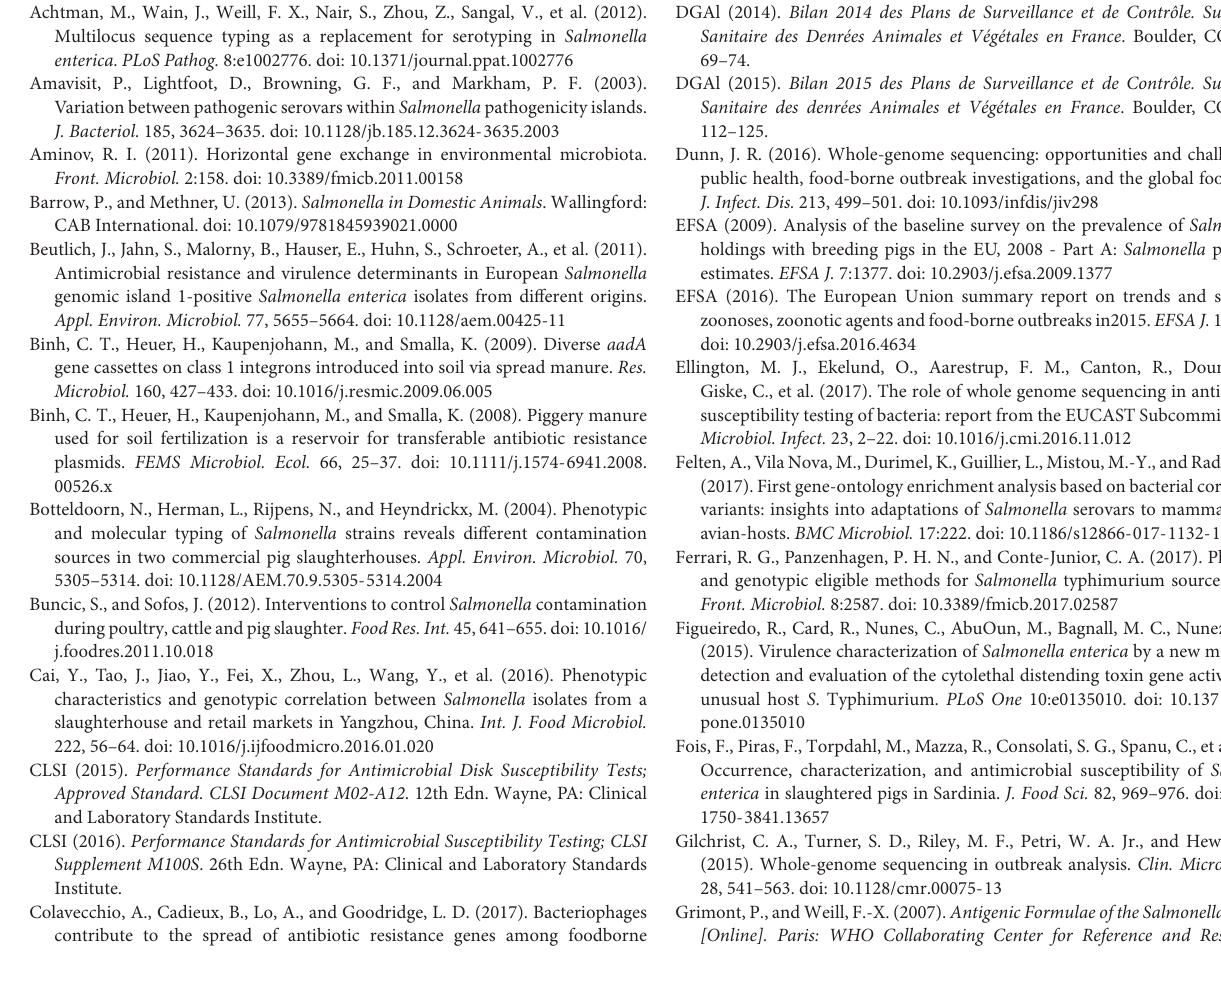
FIGURE S1 | Geographical selection plan for the strains isolated from the pork and poultry sectors. FIGURE S2 | Results of the in silico PCR for the SPI-23 into S. Derby collection. The docB gene corresponds to the coding sequence located immediately after